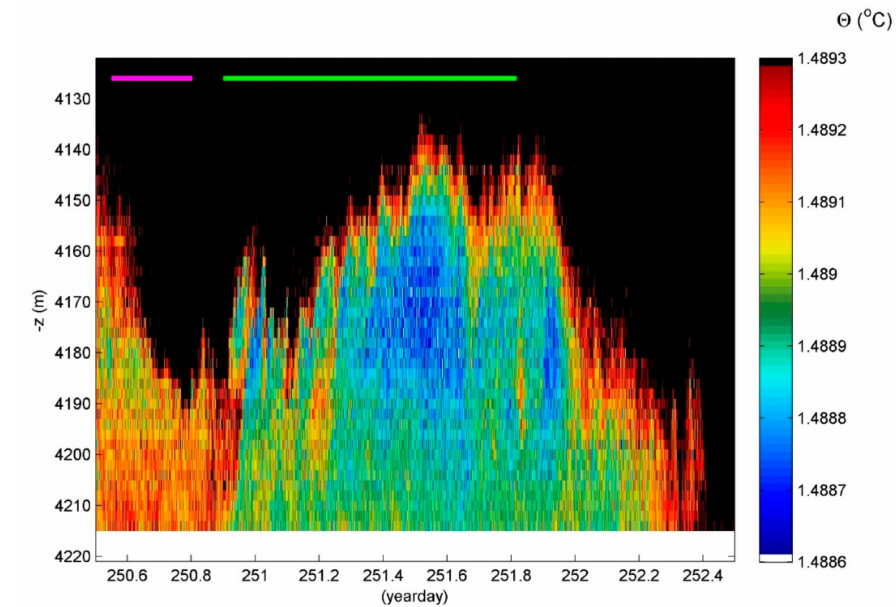
Figure 5. Lower 100 m above the bottom magnification from Figure 4a with a different color range of 0.7 mK